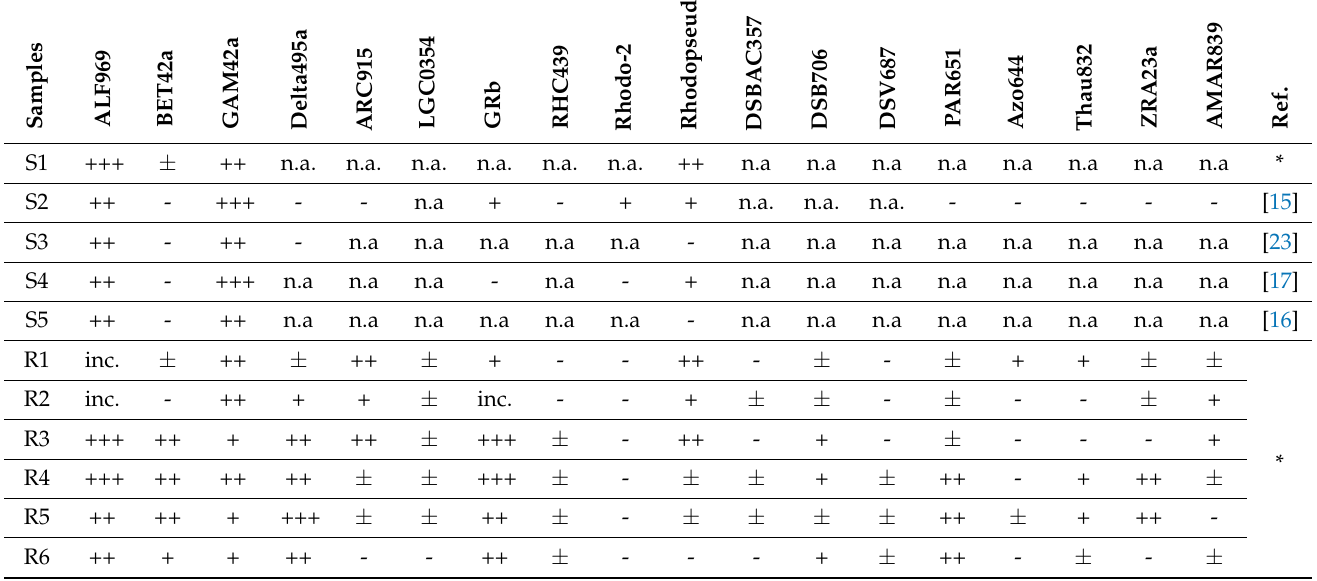
Table 4. FISH results for the PMCs fed with acetate synthetic medium (S1 to S5) and PMC fed with a fermented mixture of domestic wastewater supplemented with molasses (R1 to